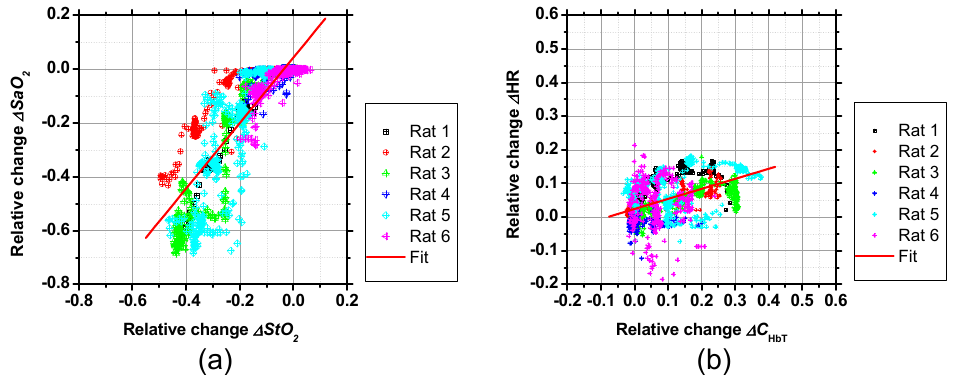
Figure 3. Scatter plots of relative changes in ( a ) SaO 2 vs. StO 2 and ( b ) C HbT vs. HR, obtained from the six rats.